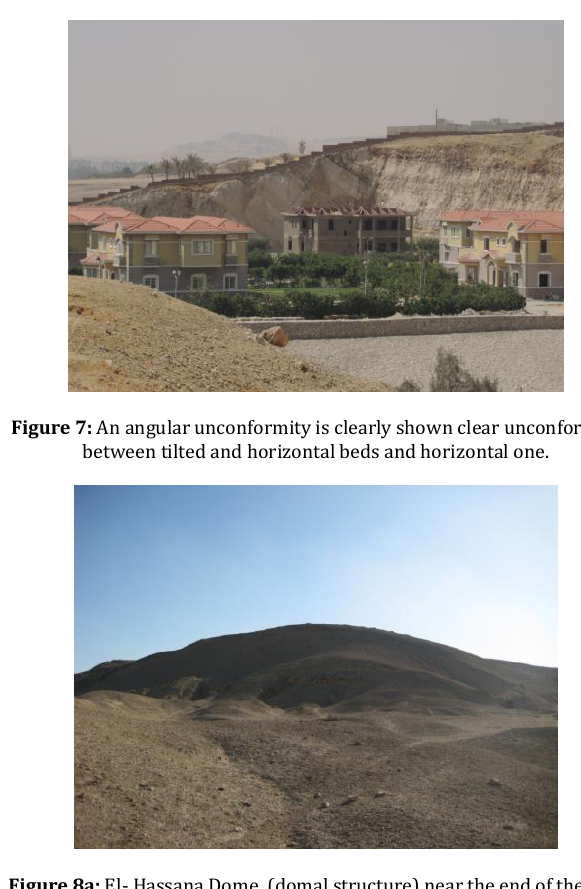
Figure 3: Plunged fold consisting of different beds from ferruginous sandstone and chalky limestone.